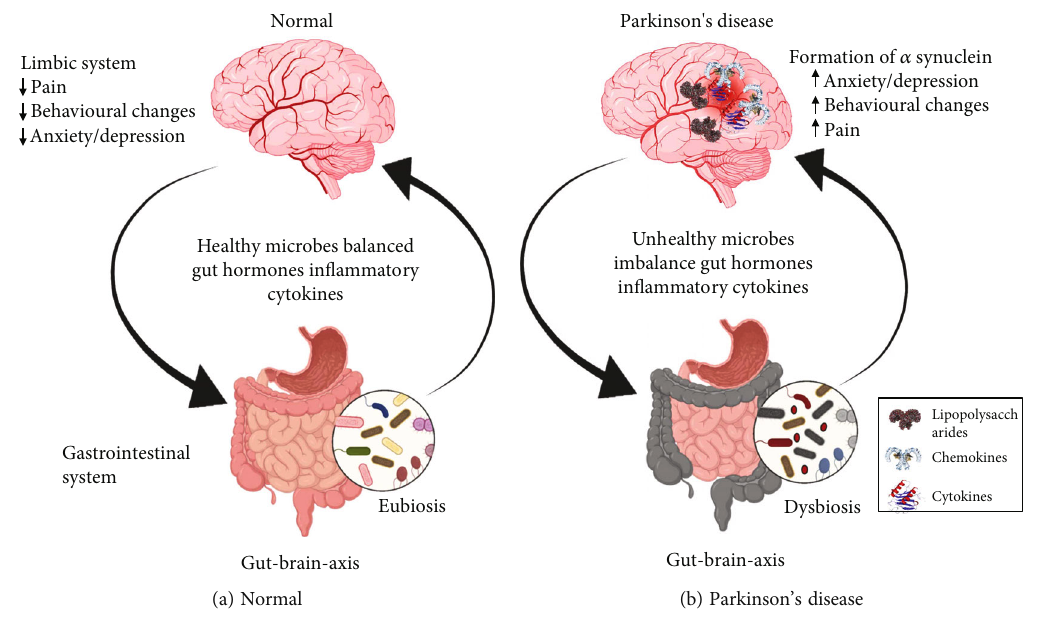
Figure 1: An illustration of microbiome-gut-brain axis in Parkinson ’ s condition. The blood-brain barrier (BBB) may be permeable to lipopolysaccharide (LPS) and other bacterial metabolites, which could allow them to enter the brain and cause the release of several chemokines and cytokines that would contribute to in fl ammation in Parkinson ’ s disease. Leaky gut also known as compromised gut epithelial barrier integrity may result from microorganisms in the lumen of the gut promoting in fl ammatory mechanisms and harming intestinal enterocytes. Bacterial metabolites, like LPS, can cross the compromised gut barrier from the lumen of the gut to the bloodstream and potentially cause systemic and neuroin fl ammation in the